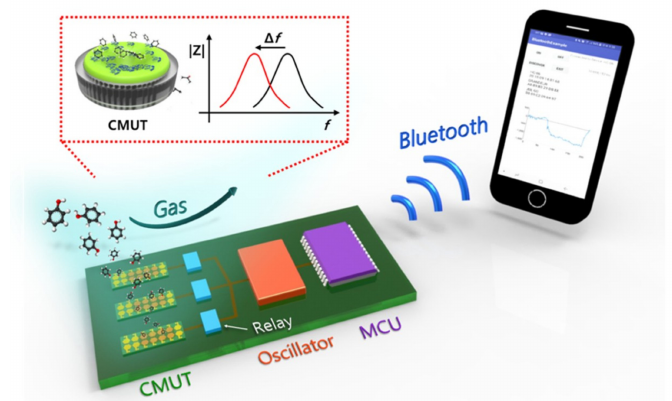
Figure 1. Conceptual schematic diagram of a wireless, portable VOC sensor system based on multiple CMUT resonant sensors and multiplex detection scheme with an actively controlled